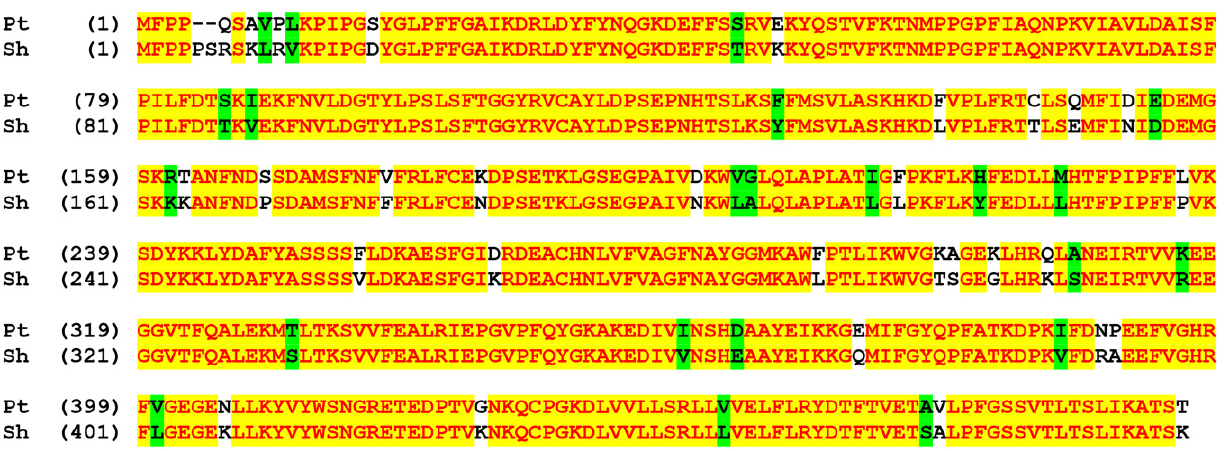
Figure 1. The pairwise alignment of CYP74C44 of S. hondurensis (Sh) vs. the putative CYP74C protein of poplar Populus trichocarpa (Pt). These two proteins share 88.7% sequence identity. The color scheme reflects the similarity of amino acid sequences.